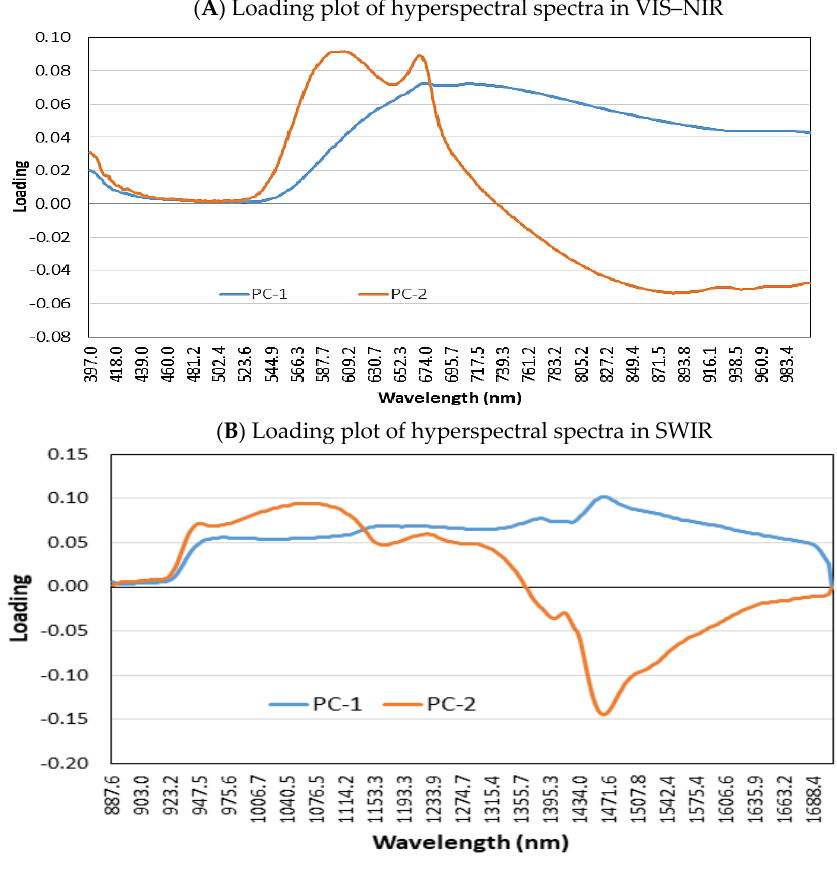
Figure 4. Loading plot of PC1 and PC2 derived from PCA of hyperspectral spectra in VIS–NIR ( A ) and SWIR band ( B ).